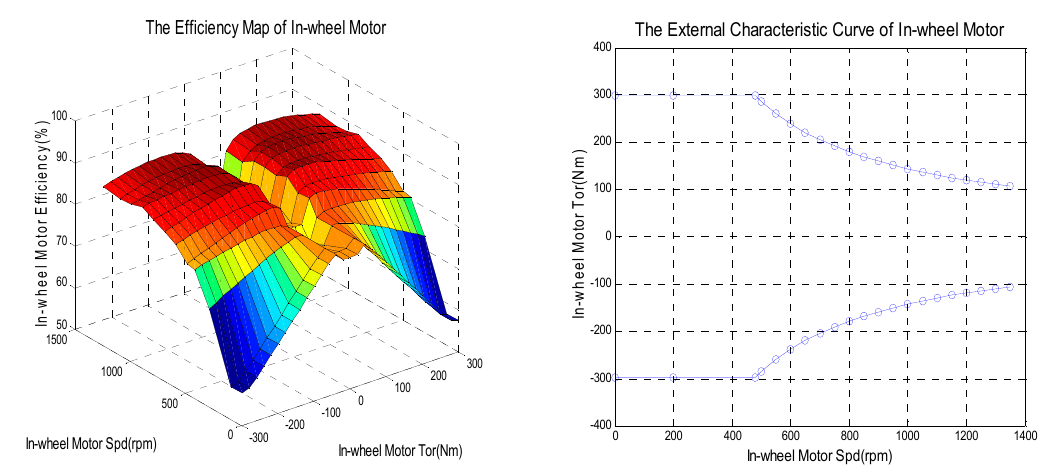
Figure 4. Working efficiency curve and external characteristic curve of in-wheel motor.